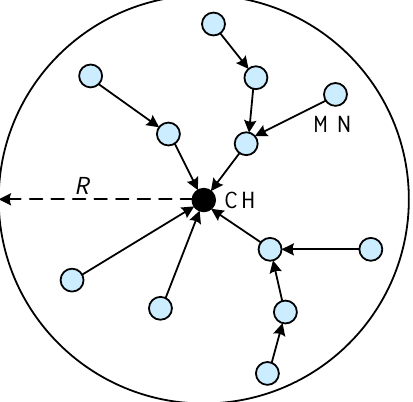
Figure 3. The Structure of Multi-level Cluster in